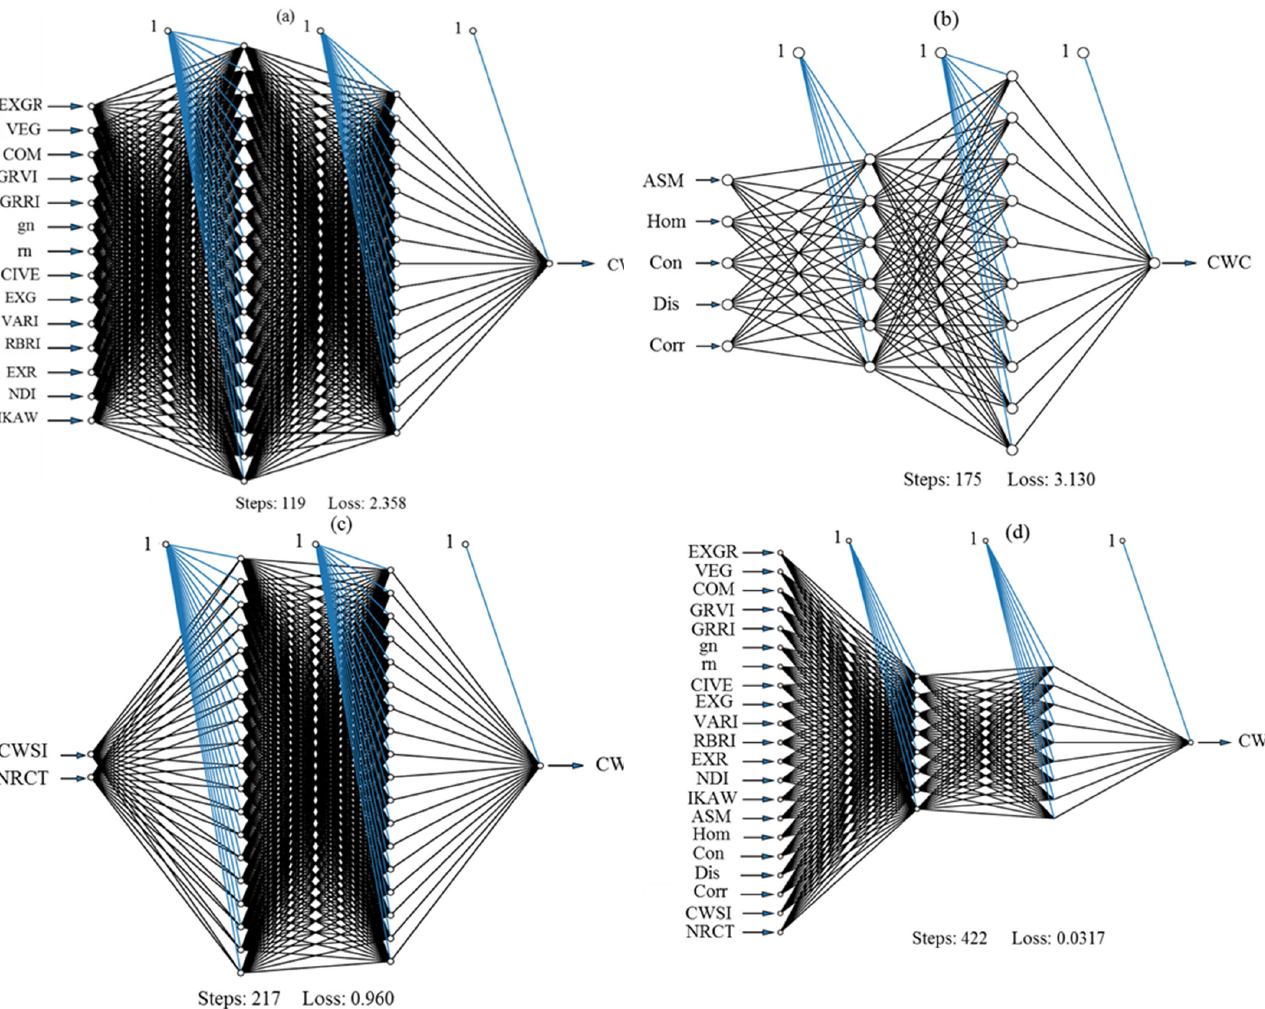
Figure 10. Neural network topology with the best ‐ combined variables: ( a ) 14VI, ( b ) 5GLCMF, ( c ) 2T, and ( d ) VI ‐ GLCMF ‐ T ‐ 21.